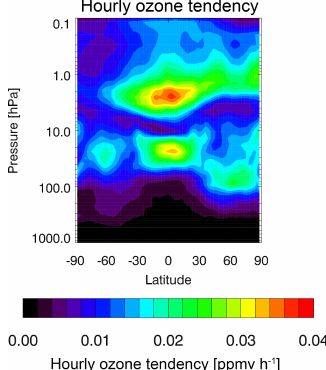
Figure 23. Zonal mean (pressure vs. latitude) plots of the ozone tendency (ppmvh − 1 ) for the truth experiment, averaged over fore- casts in the ranges of 0–1, 1–2, 2–3, 3–4, 4–5, and 5–6h for 25 November–1 December 2014. Colors show tendency with red (blue) indicating high (low)